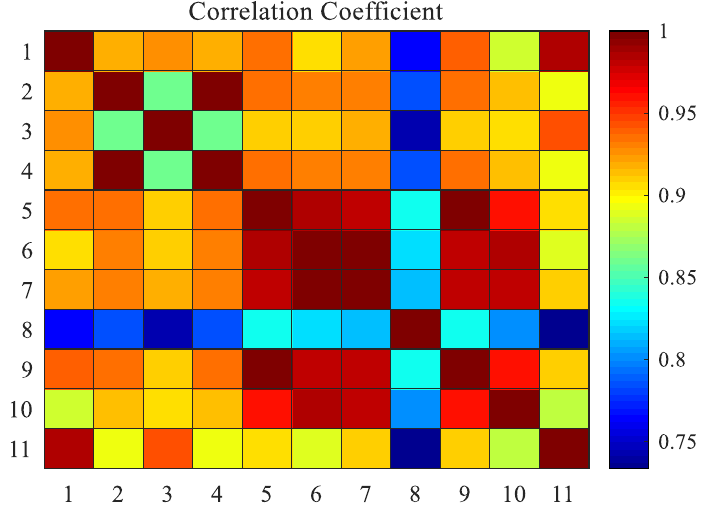
Figure 6. Spearman correlation coefficient map for preliminary selected parameters.